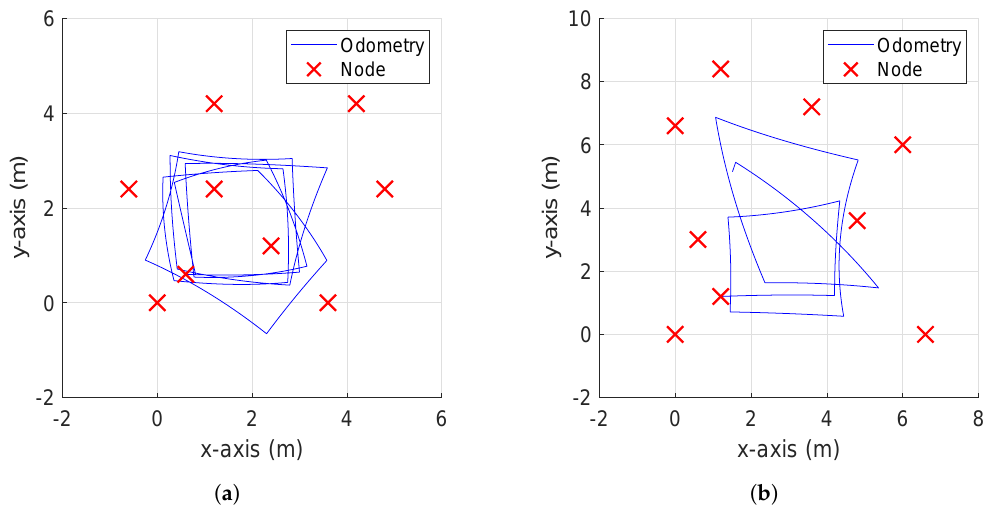
Figure 7. Deployment of nodes and odometry for ( a ) Experiment 1 and ( b ) Experiment